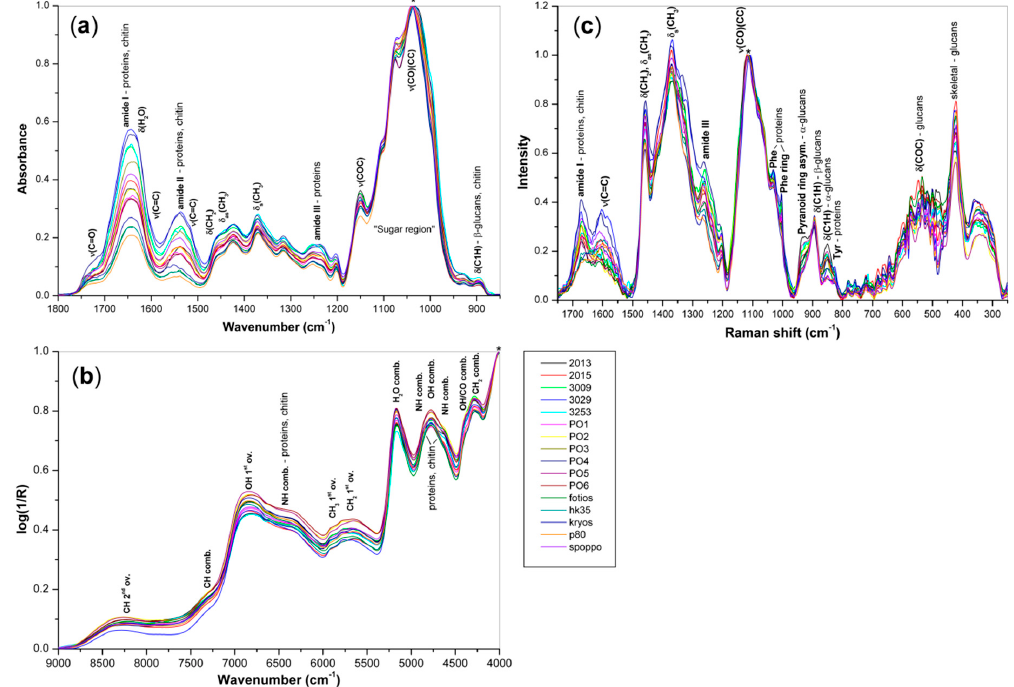
Figure 1. Average normalized spectra of sixteen P. ostreatus basidiocarp samples: ( a ) Fourier-transformed (FT) mid-infrared (FT MIR), ( b ) FT near-infrared (NIR) and ( c ) FT Raman. The asterisk indicates the peak used to normalize the spectra.